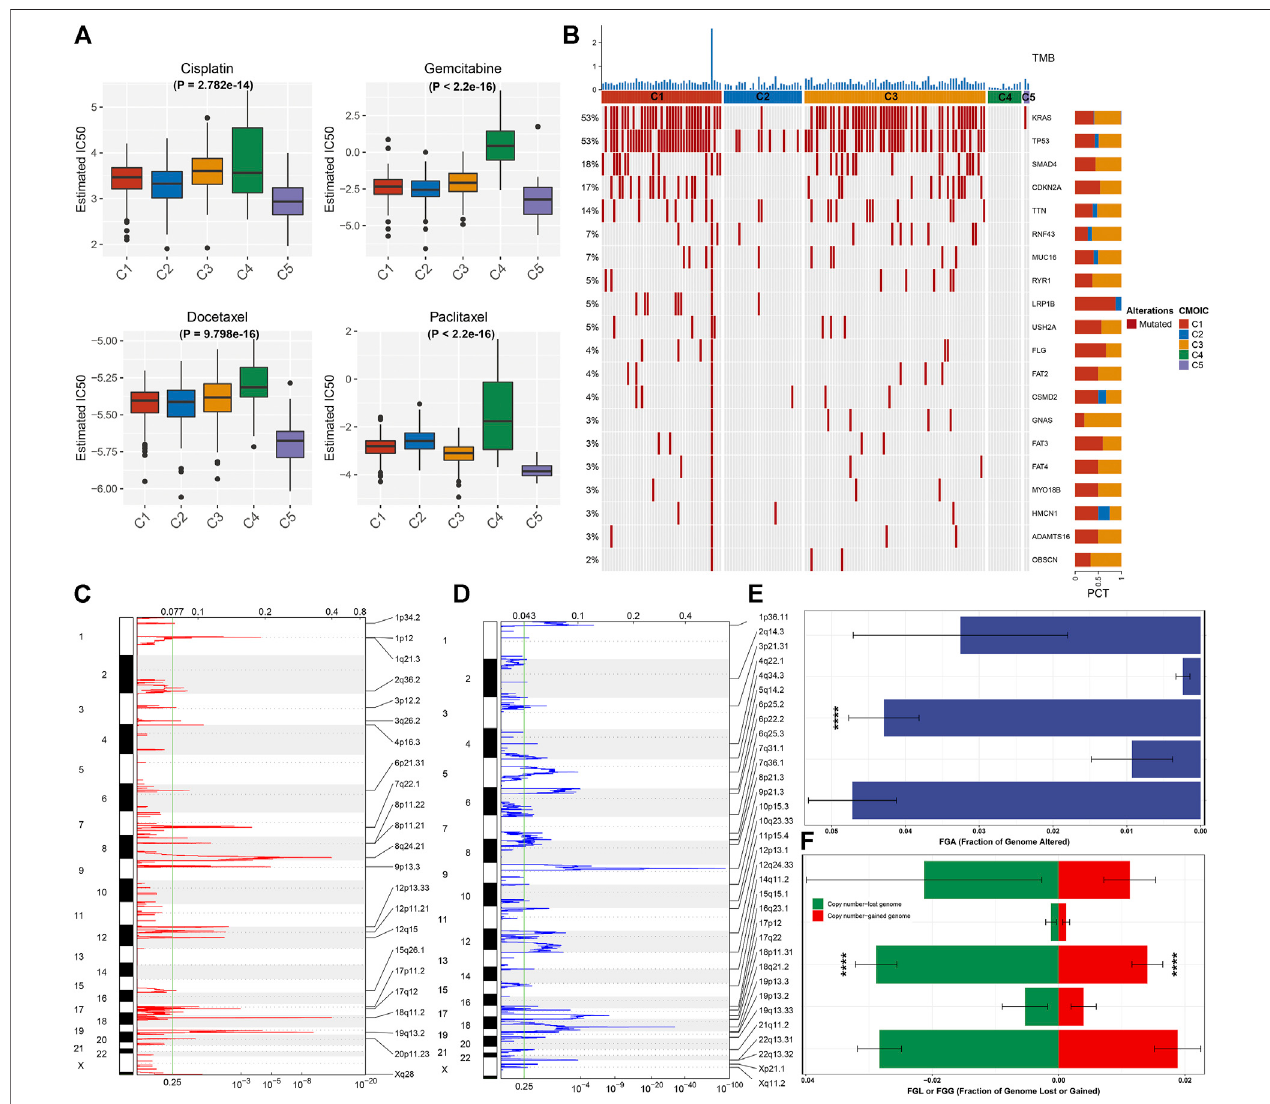
FIGURE 3 | Necroptosis subtypes with different chemosensitivity and tumor mutation features. (A) Comparison of the IC50 values of chemotherapy agents (cisplatin, gemcitabine, docetaxel, and paclitaxel) among fi ve necroptosis subtypes. (B) Waterfall diagram depicts the fi rst 20 mutated genes and TMB (upper of the panel) across necroptosis subtypes. (C,D) Chromosome arms with signi fi cant ampli fi cation and deletion (q-value < 0.25). The focal peak of ampli fi cation and deletion is separately visualized. Red indicates copy number ampli fi cation, while blue represents copy number deletion. (E) Comparison of the fraction of genome altered (FGA) among necroptosis subtypes. (F) Comparison of the copy number ampli fi cation (red) and deletion (green) in fi ve necroptosis subtypes. **** p < 0.0001.